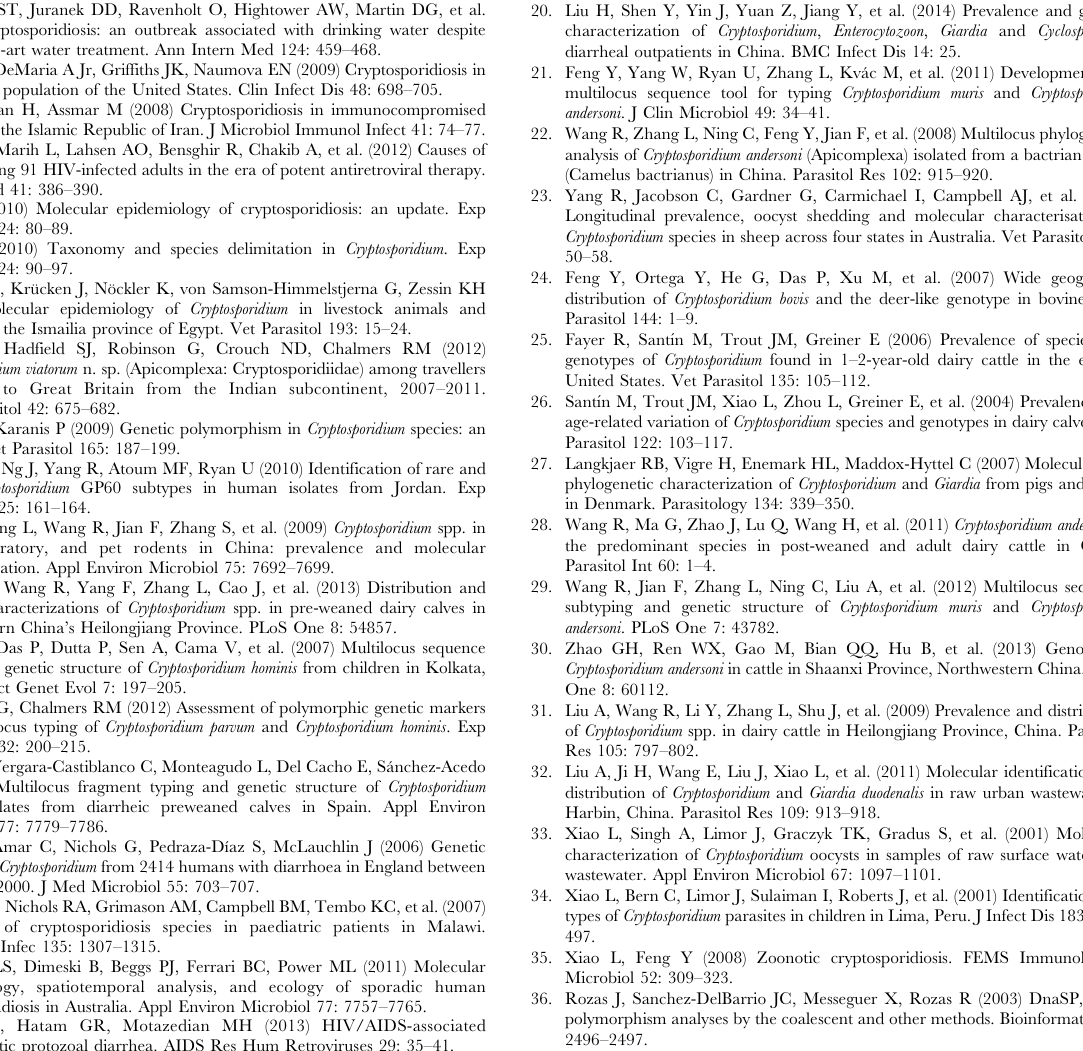
rium (LD) across the entire composite sequence by DnaSP 5.10.01